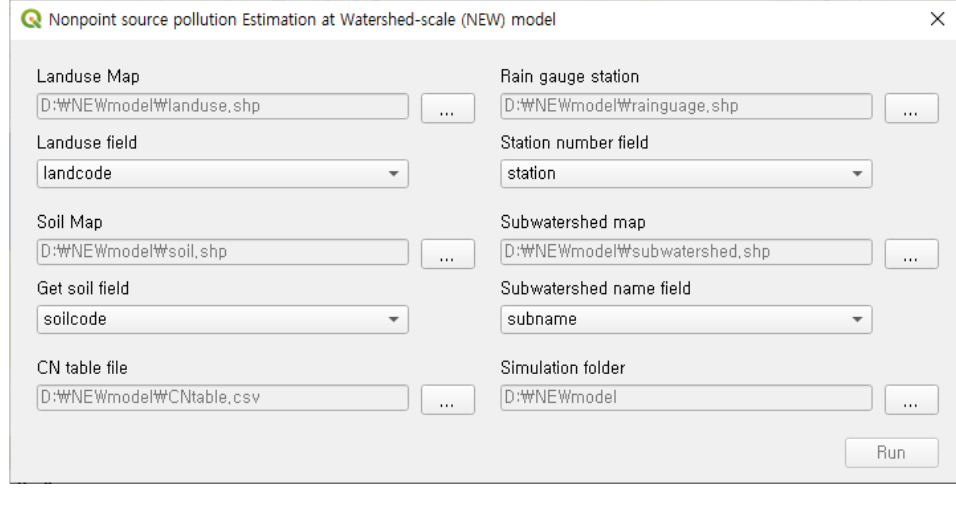
Figure 3. Interface for generating HRU information file.